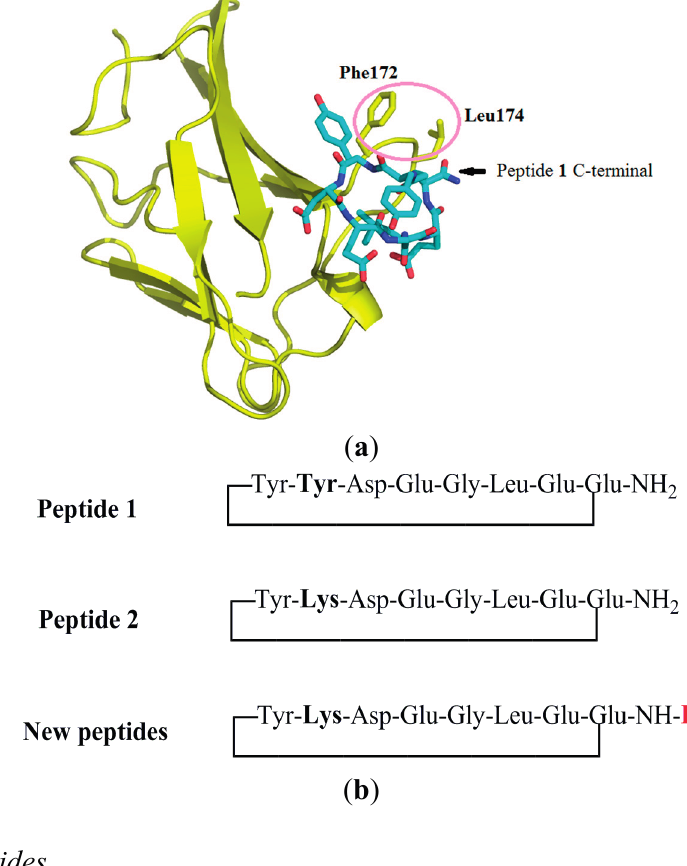
Figure 2. ( a ) Docking model of peptide 1 (in cyan) with the VEGFR1 D2 domain (in gold) [25]. The C-terminal amide is indicated by an arrow. ( b ) Optimization of peptide 1 . Peptide 2 with Tyr replaced by a Lys retains peptide’s receptor binding affinity but with improved solubility and creates a potential labeling site [26]. New peptides are designed with C-terminal substitutions expected to create interactions with Phe172 and Leu174 (circled in pink) belonging to the VEGFR1 D2